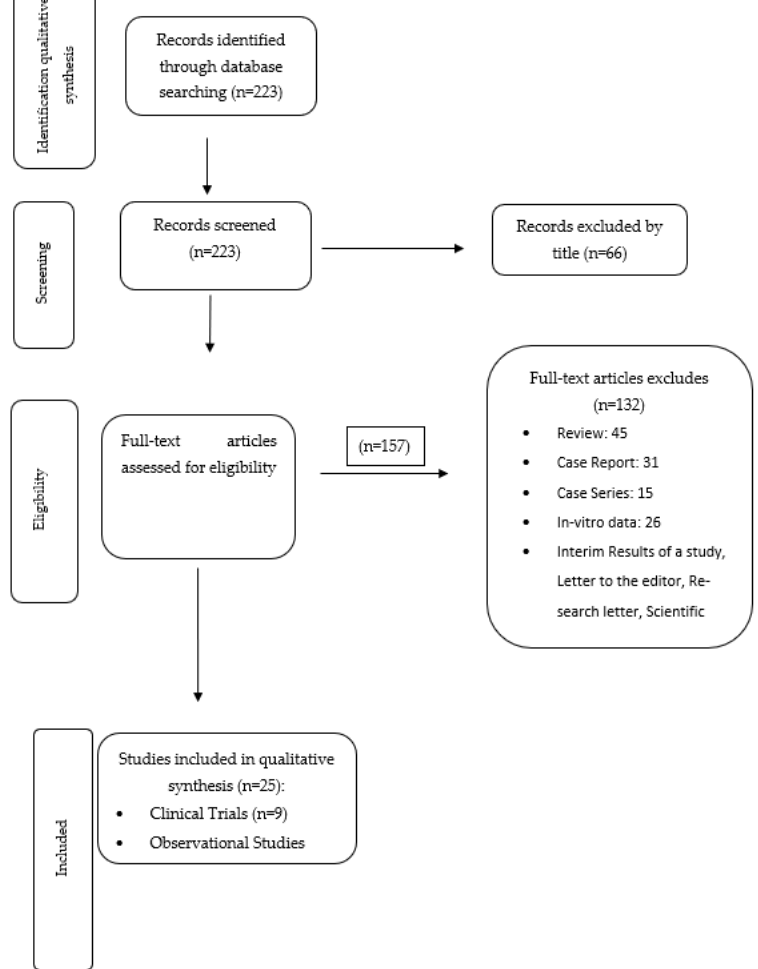
Figure 1. Flow diagram of study